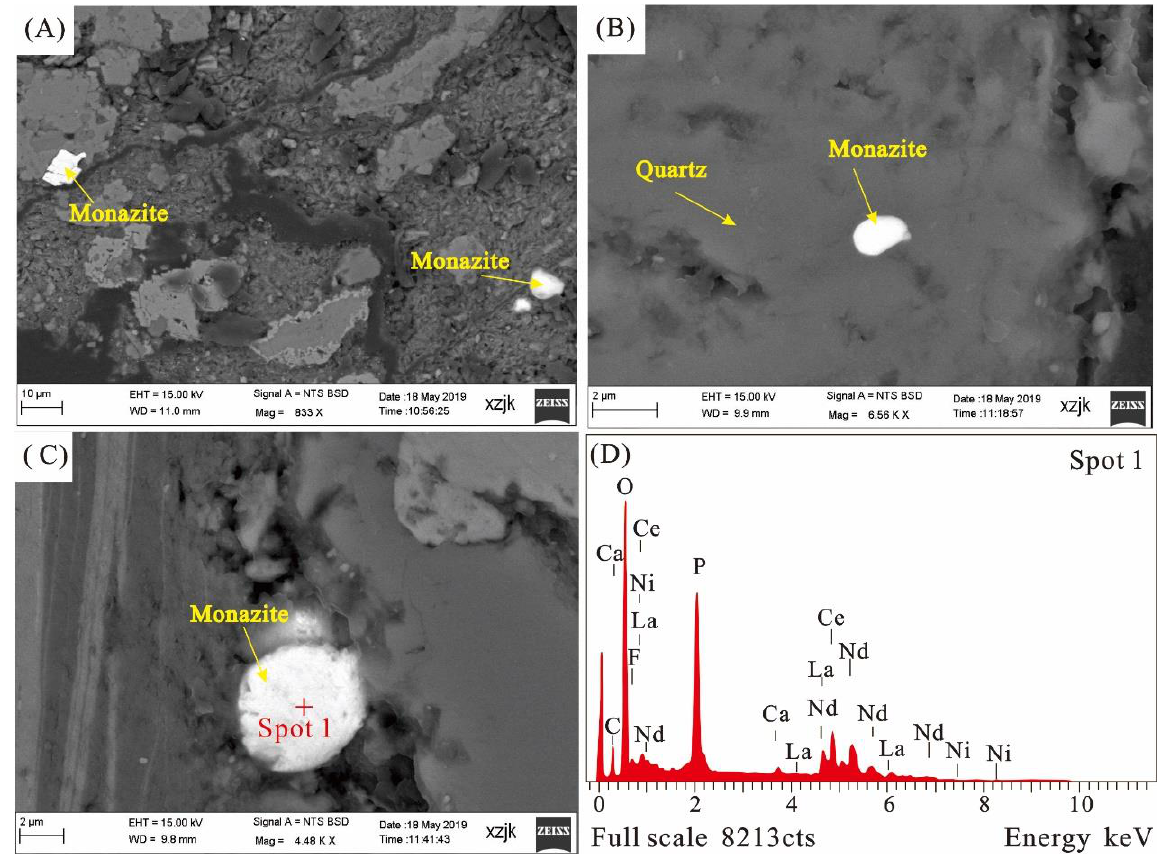
Figure 12. Monazite in samples from Junde mine. ( A ) Sample JD-26-04; ( B ) Sample JD-26-06; ( C ) Sample JD-26-07; ( D ) EDS spectrum of Spot 1 in Figure 13C.